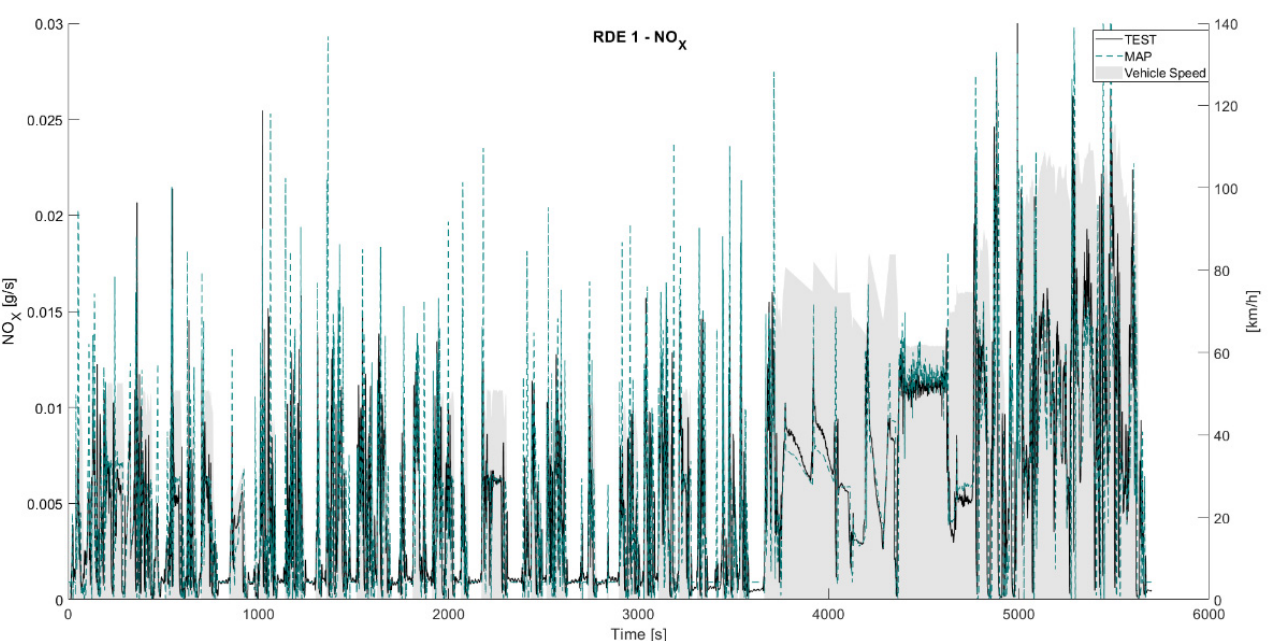
Figure 12. RDE 1 NO X [g/s] emissions test versus engine map.